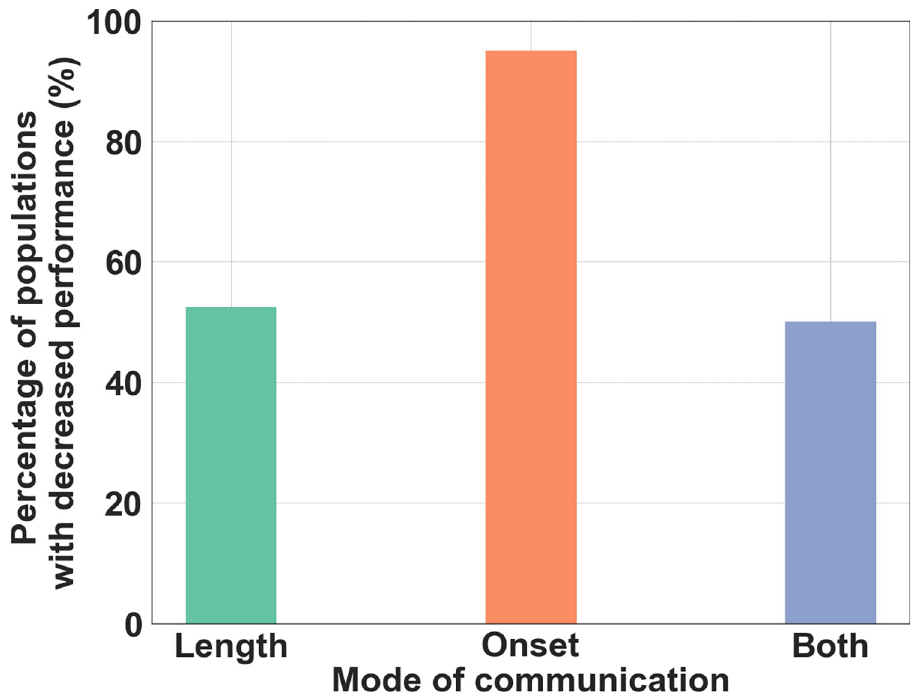
Fig 5. Percentage of populations with decreased performance depending on communication mode. Percentage of the populations (n = 40) where performance was significantly (Mann-Whitney U test, P < 0.01) decreased by preventing receivers from using information on the timing of signal onset-delay and/or duration. Length (green bar) represents the percentage of populations where performance was decreased when constraining the signal duration. Onset (orange bar) represents the percentage of populations where performance was decreased when shifting signal onset-delay. Both (purple bar) represents the percentage of populations where performance was decreased when altering either the onset-delay or signal duration.